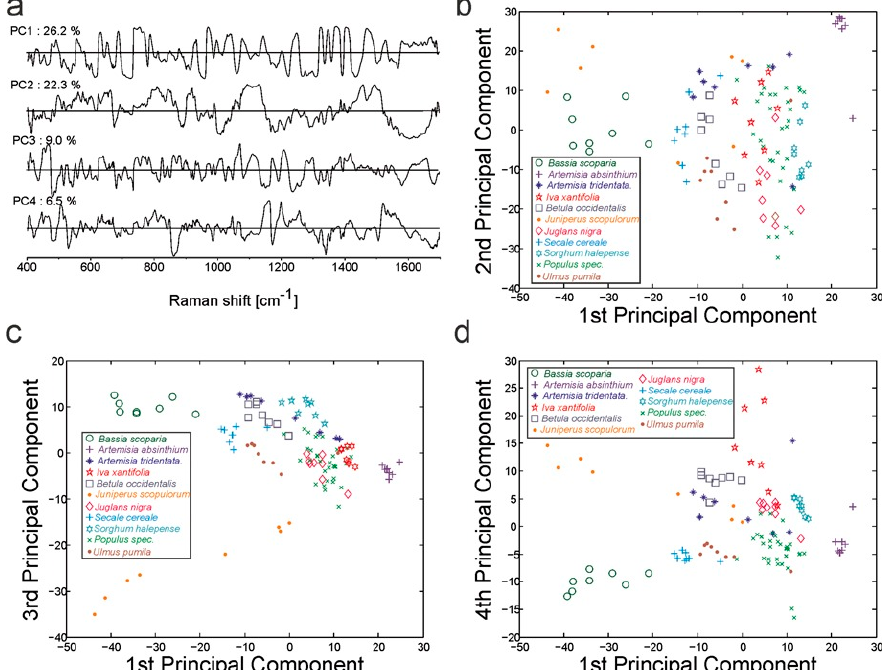
Figure 12. PCA results using the spectral range of 400–1700 cm − 1 of 112 average SERS spectra from 14 different commercially available pollen species. Loadings of the first four PCs ( a ) as well as the scores of the first and second ( b ), first and third ( c ), and first and fourth PC ( d ) are shown. PCA was done with standardized first derivatives of the mean spectra of 500 vector-normalized spectra. Reprinted with permission from [72] without modification. Copyright 2016 John Wiley and Sons.